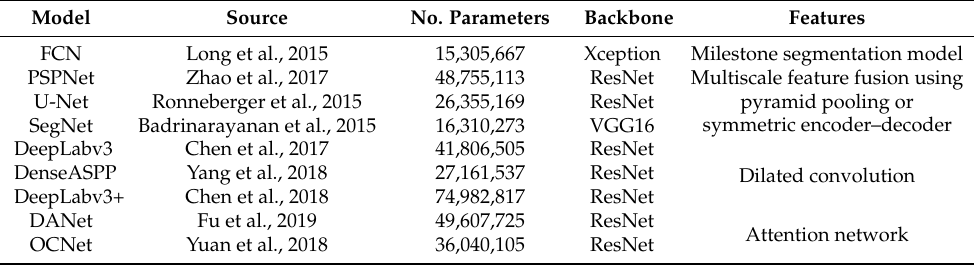
Table 1. Models evaluated in this